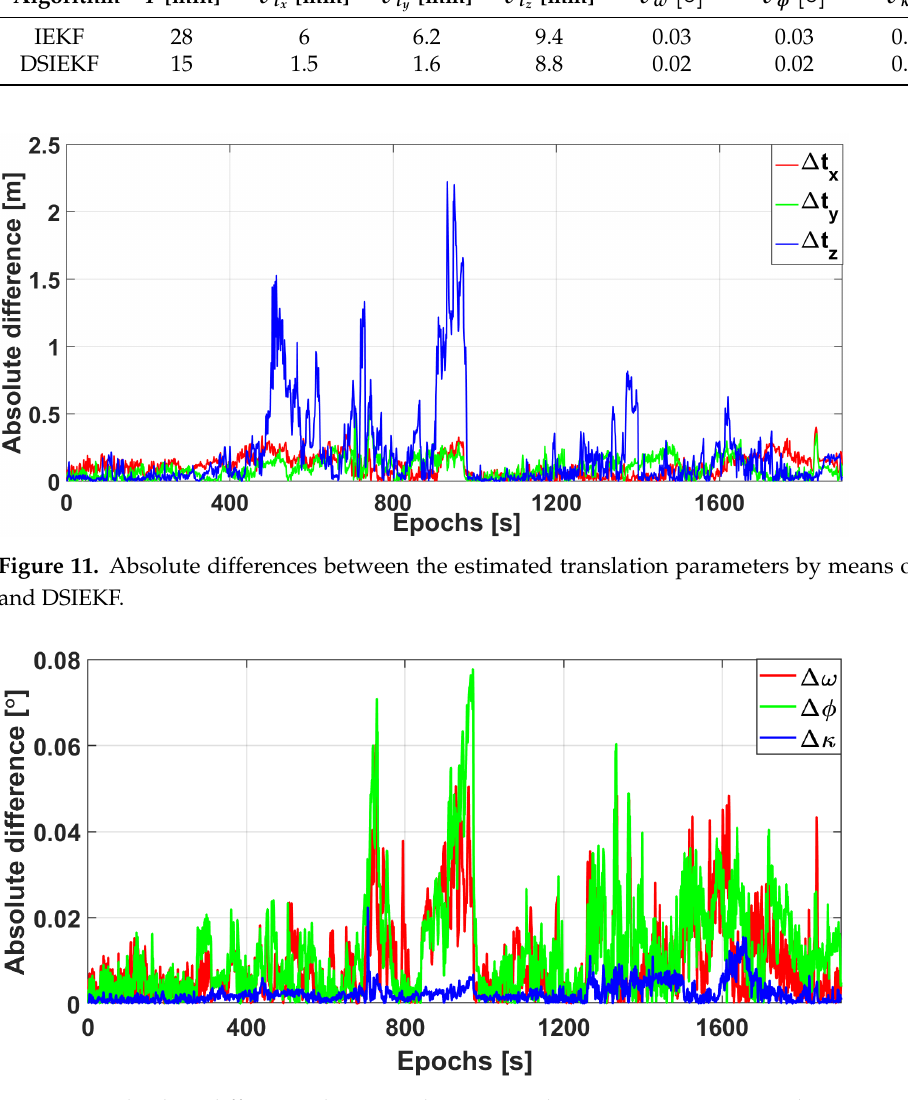
Figure 12. Absolute differences between the estimated orientation parameters by means of IEKF and